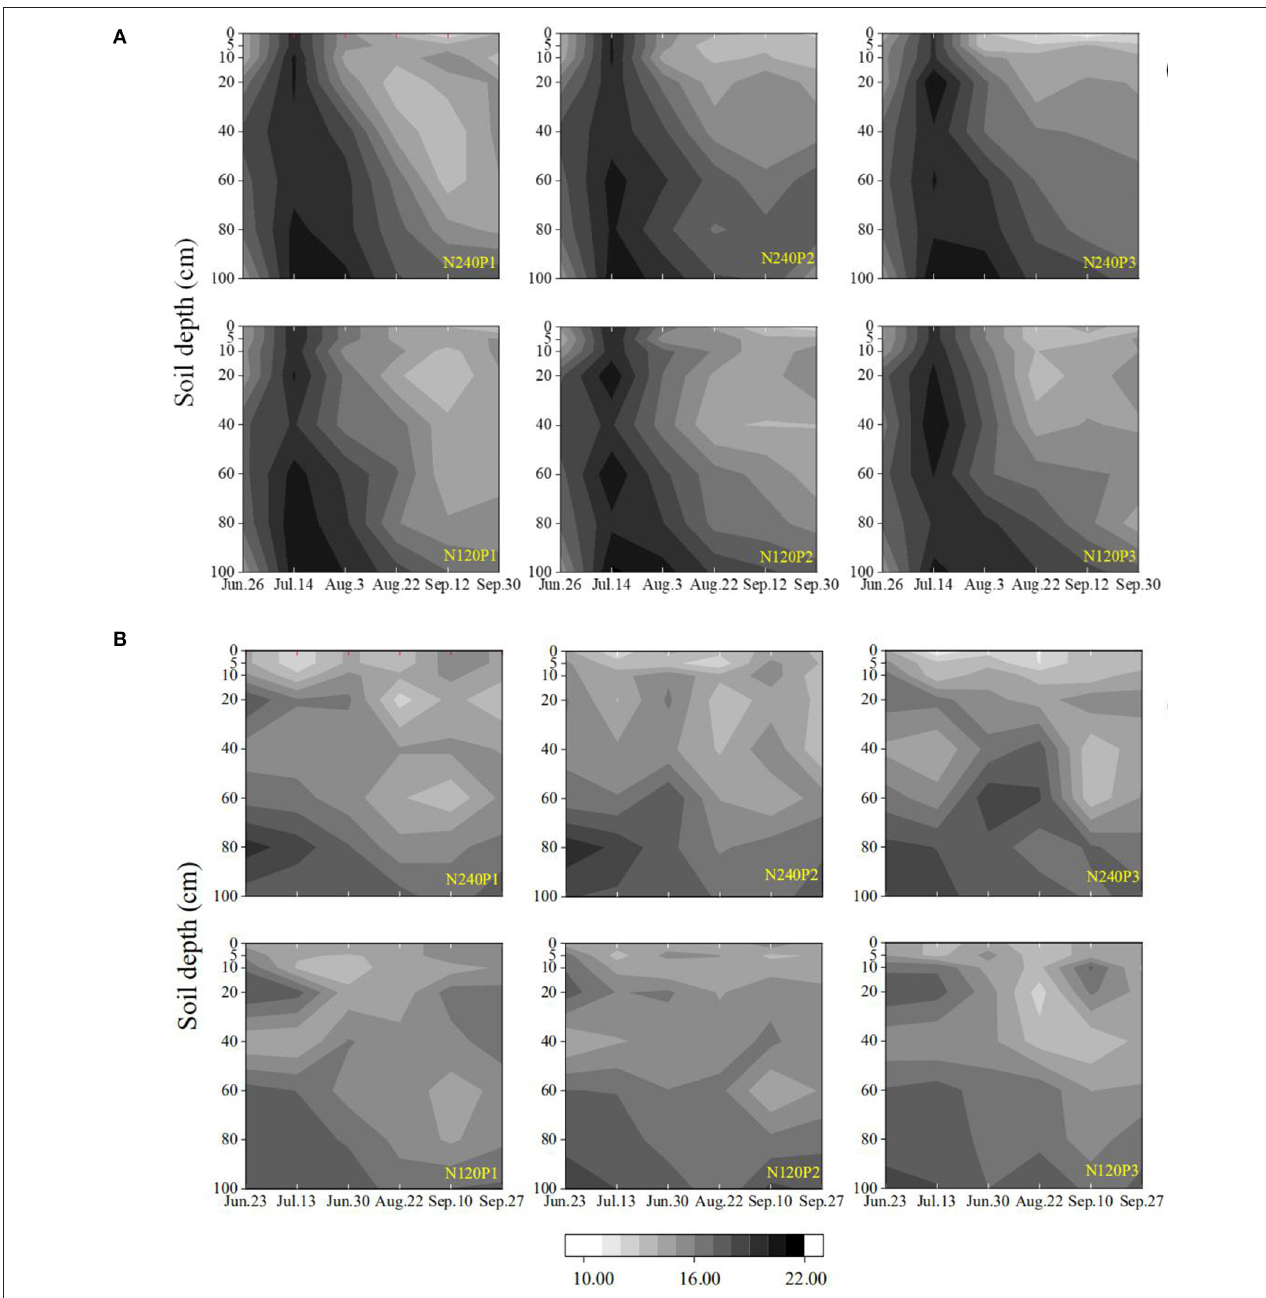
FIGURE 7 | Spatiotemporal variations in soil moisture content under different treatments (see Figure 1A ) in 2016 (A) , and 2017 (B) .